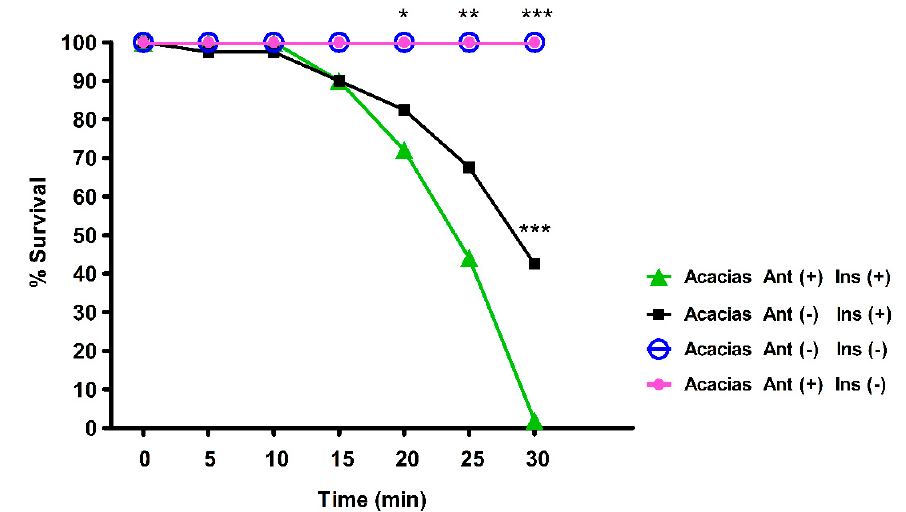
Figure 3. Mortality of lambda-cyhalothrin resistant mosquitoes treated with antibiotics (Ant). Females from the highly resistant Acacias strain F6 (selected by treatment with lambda-cyhalothrin) were treated (Ant + ) or not (Ant − ) with 50 U / mL penicillin / 50 µ g / mL streptomycin. The mortality after exposure to the insecticide lambda-cyhalothrin (Ins + ) for 30 min was evaluated. Mosquitoes treated or not with antibiotics (Ant +/ Ant − ) but not exposed to insecticide (Ins − ) were used as controls. Statistical analyses included two-way ANOVA and Bonferroni tests (*** p < 0.001; ** p < 0.01; * p < 0.05). There was a significant di ff erence at 30 min between Ant ( − ) Ins ( + ) and Ant ( + ) Ins ( + ). These two treatments were significantly di ff erent from controls without insecticide at 20, 25, and 30 min.